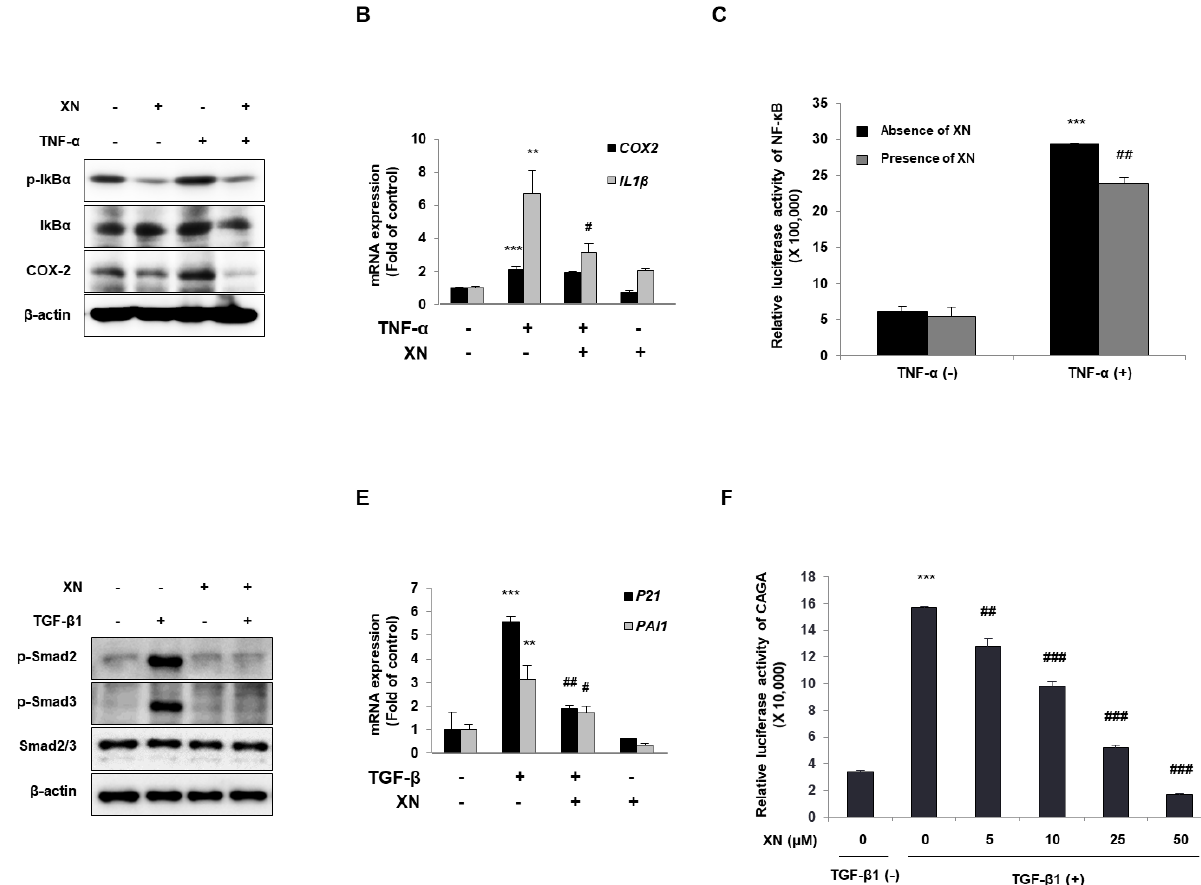
Figure 3. Reduction of NF- κ B and TGF- β signaling pathways by XN in SW620 cells. ( A ) Protein expressions of p- IκBα, IκBα, COX -2, and β -actin using immunoblotting. ( B ) The mRNA expression of IL- 1β and Cox-2 using qRT-PCR. Data are means ± SD for three separate experimental samples. Data were analyzed by Tukey’s test (*** p < 0.001, ** p < 0.01 vs. vehicle cells; # p < 0.05 vs. TNF- α -